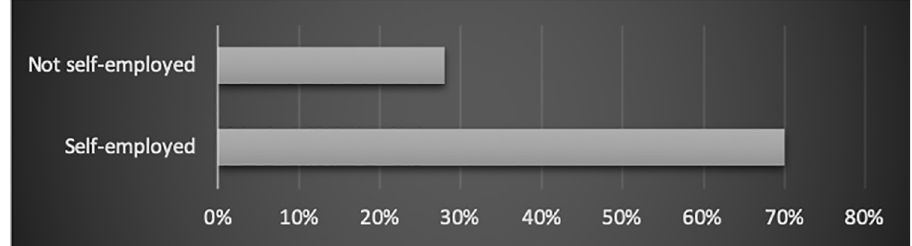
Fig 6. The relation between being self-employed vs. not being self-employed and employees’ work-life balance (% of people in the category).